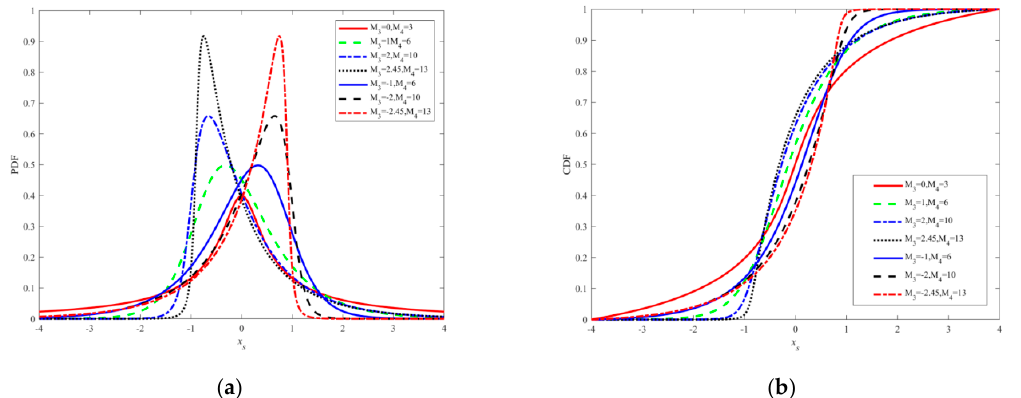
Figure 4. Representation functions of epistemic variables (a) probability density function (PDF) (b) cumulative CDF.